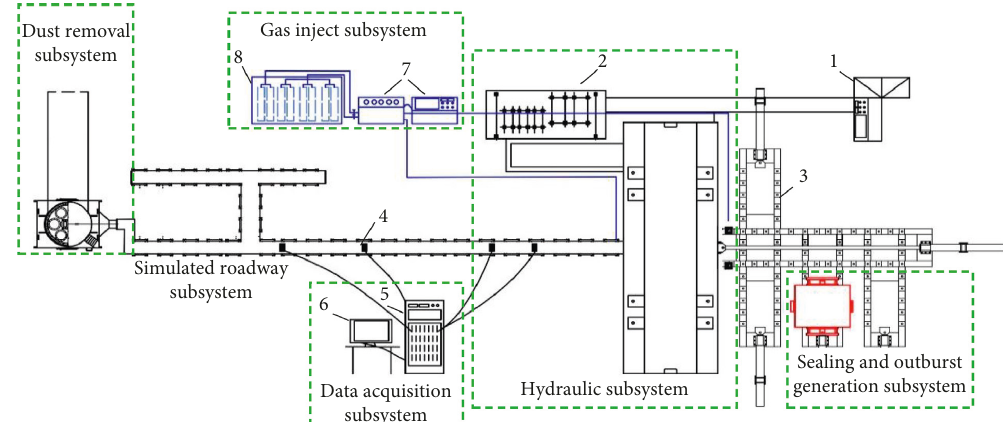
Figure 3: Schematic diagram of outburst simulating device. 1, hydraulic control console; 2, hydraulic pump; 3, container orbit; 4, sensor; 5, multifunction data acquisition controller; 6, display and operating platform; 7, inflatable controller; and 8, high-pressure gas cylinder group.